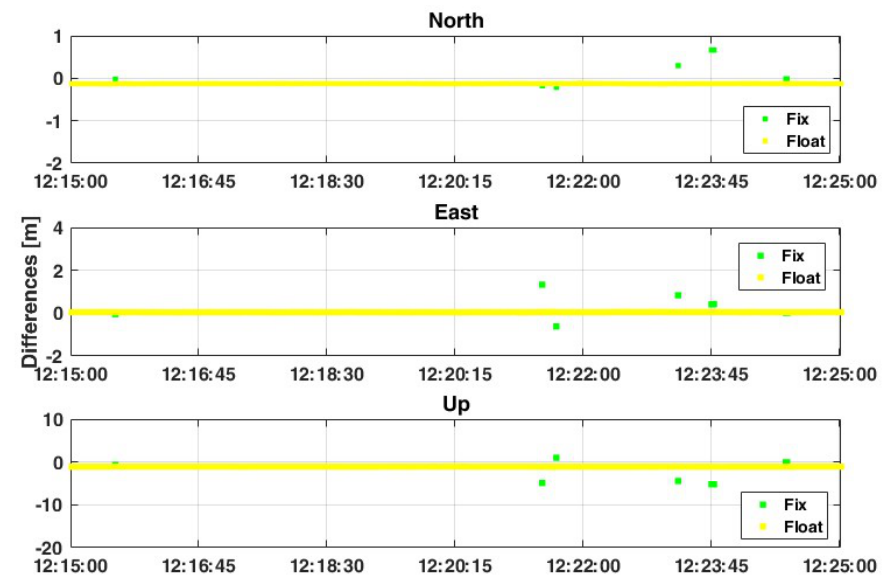
Figure 6. Positioning results considering case 1, with GPS-only constellation, L1 + L5 frequencies, “continuous” method for the ambiguity resolution and ratio = 3.